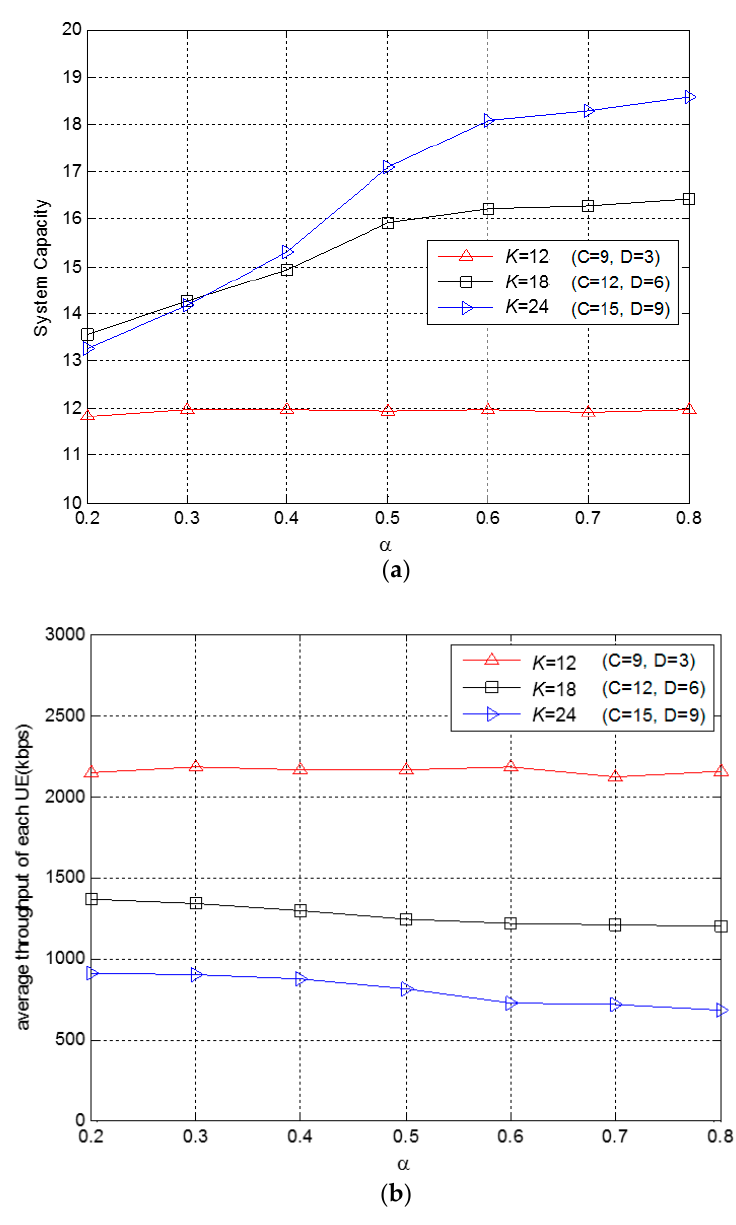
Figure 8. The comparisons of ( a ) system capacity and ( b ) throughput for different weighting α .